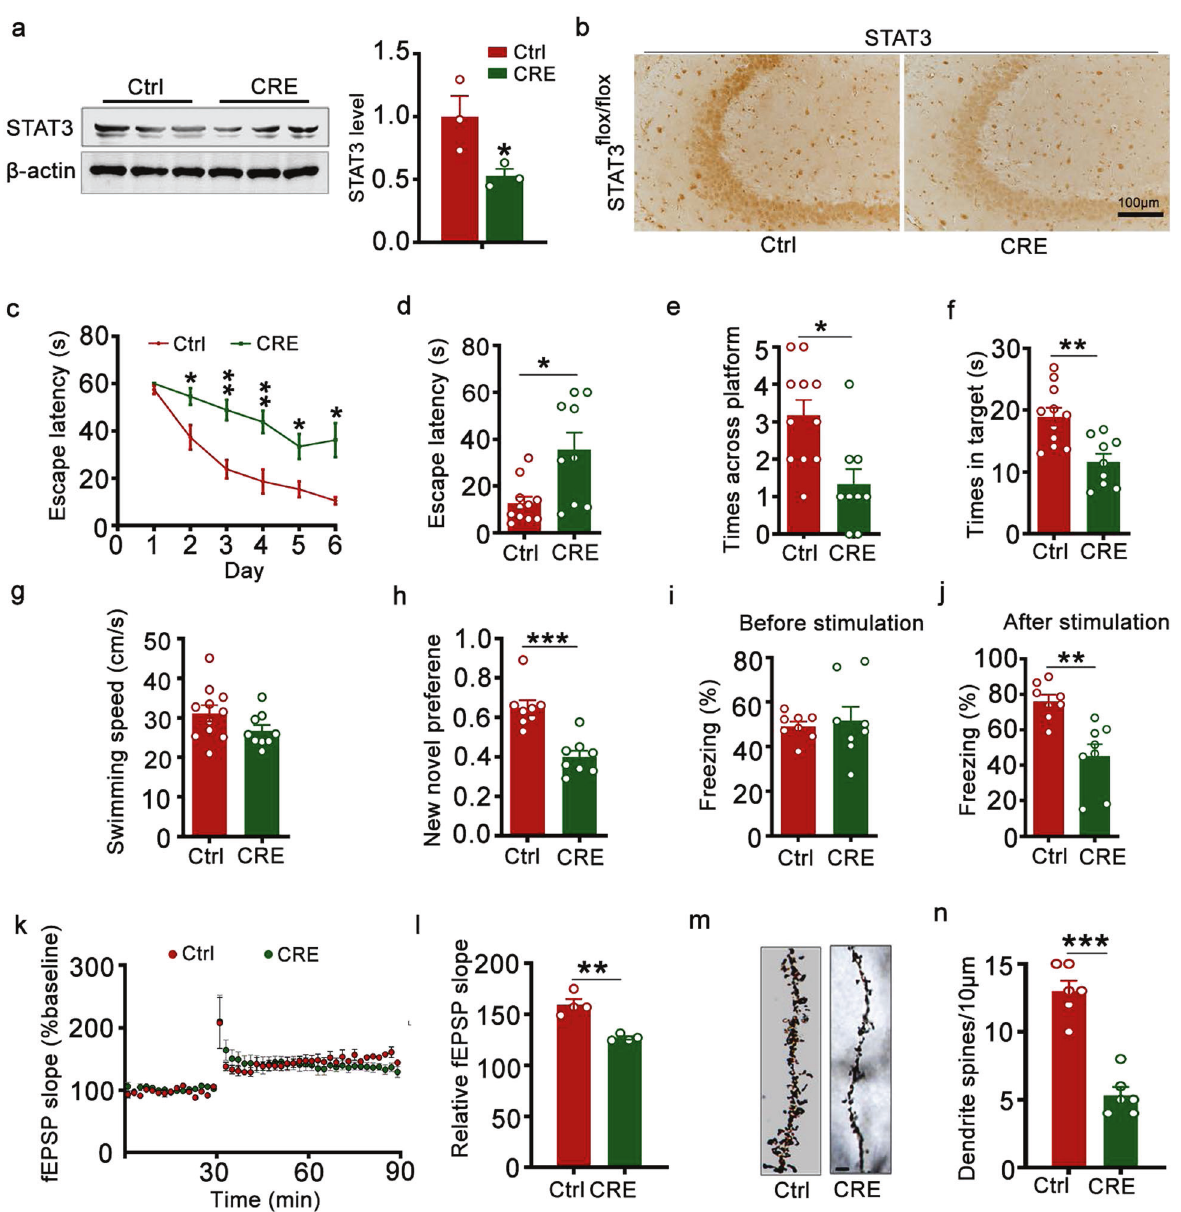
Fig. 4 Downregulation of STAT3 induced synaptic impairments and memory de fi cits in STAT3 fl ox/ fl ox mice. a , b AAV-Cre was stereotaxically injected into the hippocampal CA3 of 2-month-old STAT3 fl ox/ fl ox mice. One month later, downregulation of STAT3 was con fi rmed by Western blotting ( a ) and immunohistochemical staining ( b ). Two-tailed Student ’ s t test, p = 0.031, n = 3. c STAT3 knockdown induced spatial learning de fi cits during Morris water maze (MWM) training. Two-way repeated measures analysis of variance (ANOVA) followed by the Bonferroni ’ s post hoc test, [day 2] p = 0.018, [day 3] p = 0.001, [day 4] p = 0.003, [day 5] p = 0.013, [day 6] p = 0.014, nCtrl/CRE = 11/9. STAT3 knockdown induced spatial memory de fi cits shown by the increased escape latency to reach the platform quadrant ( d ), the decreased crossing time in the platform site ( e ), and time spent in the target quadrant ( f ) measured at day 7 by removal of the platform in MWM test; no motor dysfunction was seen ( g ). Two-tailed Student ’ s t test; d p = 0.029; e p = 0.033; f p = 0.003; nCtrl/CRE = 11/9. h STAT3 knockdown induced cognition impairment shown by the decreased time spent in exploring the new novel object. Two-tailed Student ’ s t test, p < 0.001, n = 8. i , j STAT3 knockdown impaired long-term memory as shown by the decreased freezing time measured in the fear conditioning test. Two-tailed Student ’ s t test, j p = 0.0037, n = 8. STAT3 knockdown decreased slopes of fi eld excitatory postsynaptic potentials (fEPSP ( k )) recorded in hippocampal CA3, and quantitative analysis ( l ). Two-tailed Student ’ s t test, p = 0.0013, n = 7 – 8 slices from 4 mice per group. m , n STAT3 knockdown decreased the density of dendritic spines detected by Golgi staining. Scale bar, 5 μ m. Two-tailed Student ’ s t test, p < 0.001, n = at least 22 neurons were analyzed from 6 mice per group. Data were presented as mean ±